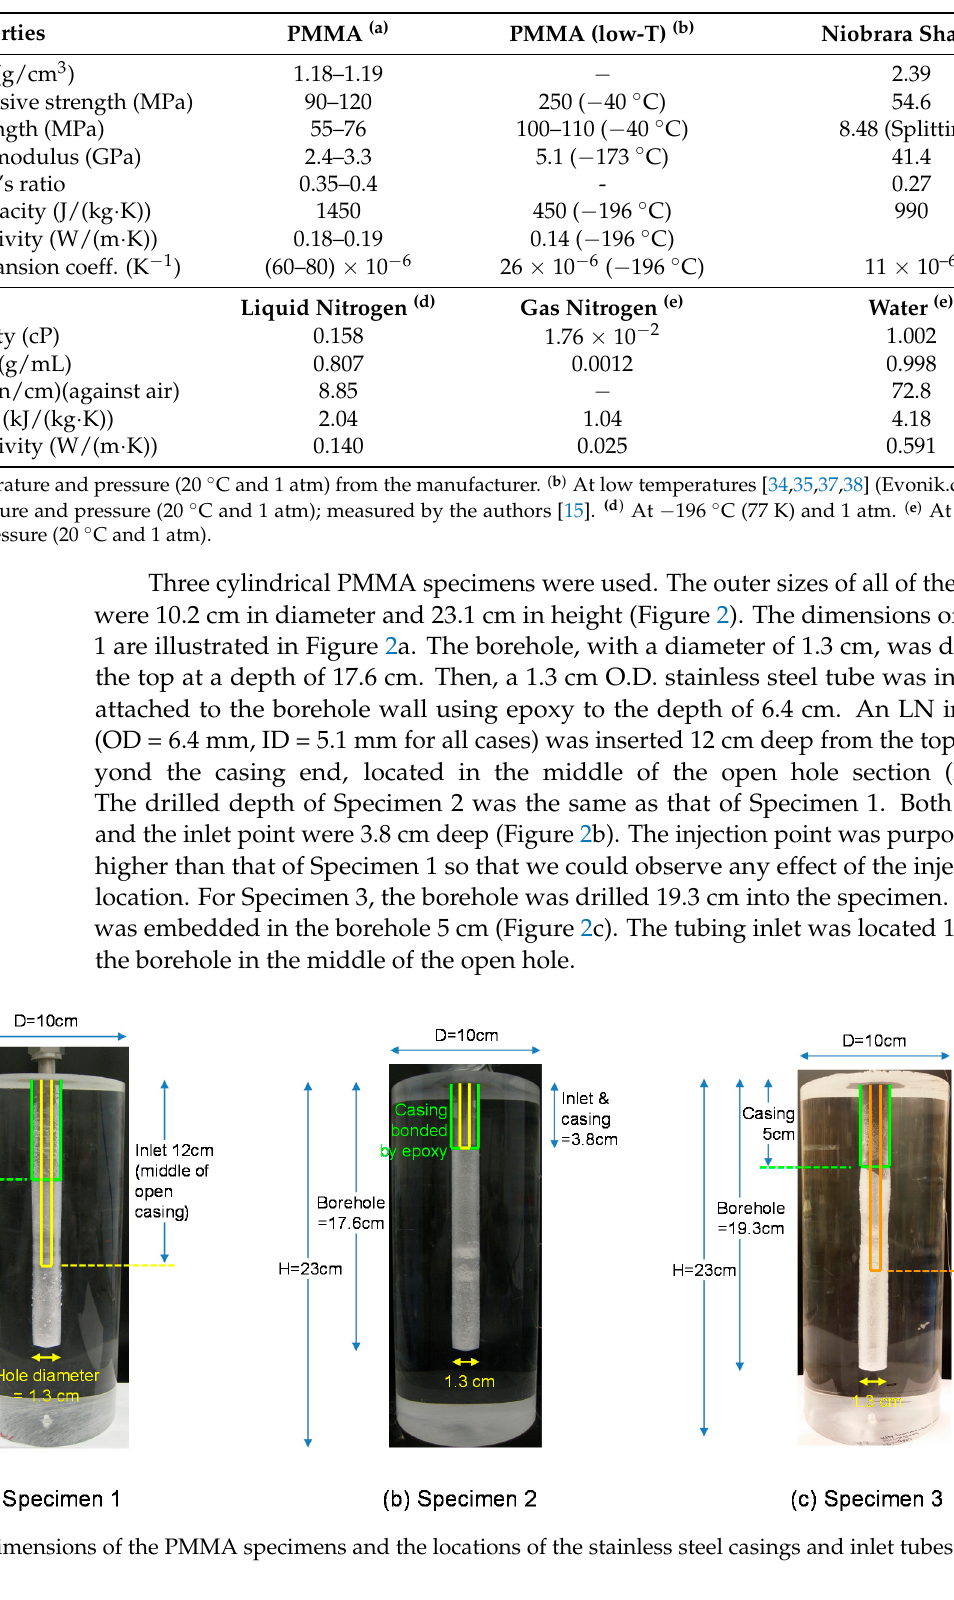
Table 1. Properties of PMMA used and liquid nitrogen. The properties of shale, gas nitrogen, and water shown for comparison.